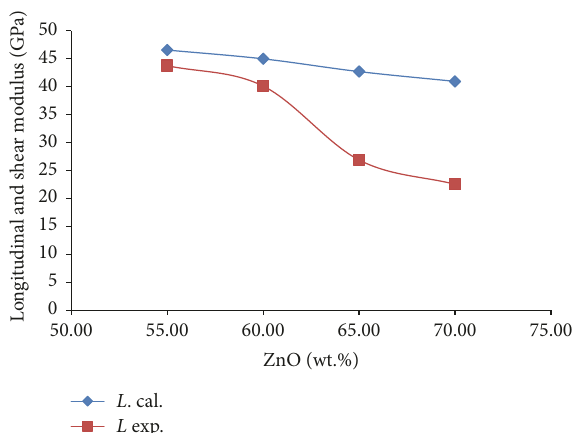
Figure 15: Experimental and theoretical bulk modulus versus wt.% of ZnO in ZnO–SiO 2 samples.